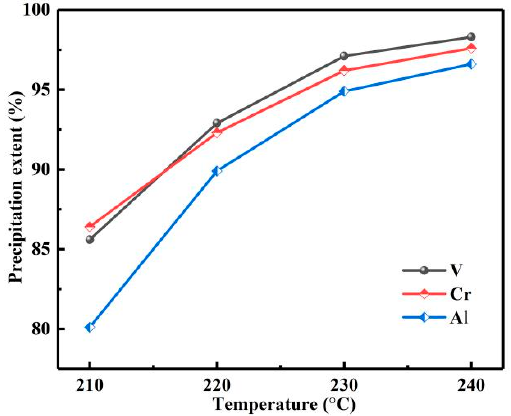
Figure 19. Influence of reaction temperature on precipitation extents.